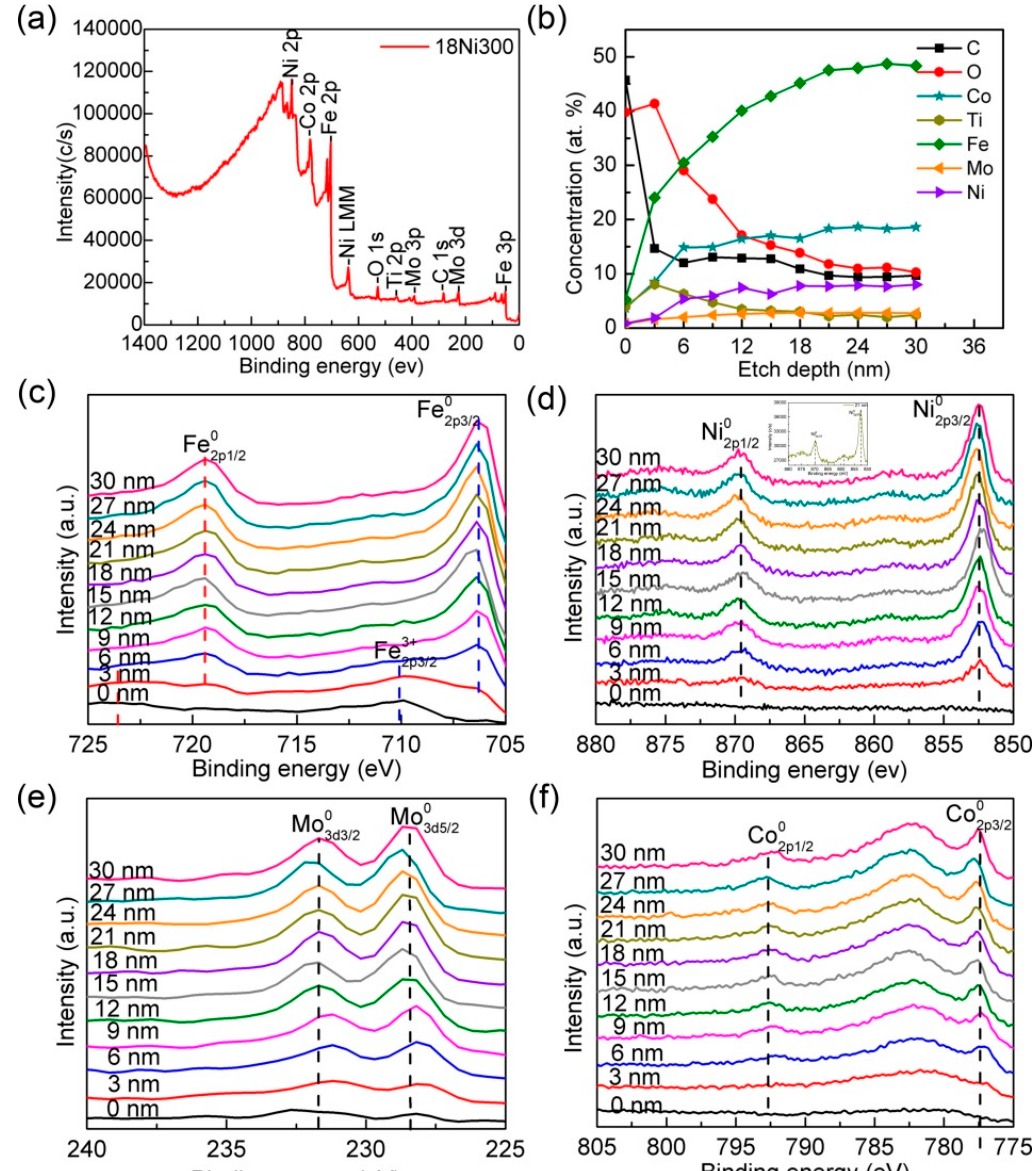
Figure A3. ( a ) XPS survey spectrum and ( b ) depth profile analyses of element concentrations, and detailed XPS spectra of ( c ) Fe, ( d ) Ni, ( e ) Mo and ( f ) Co on the surface of 18Ni300 powders in the as-received state and after ion etching up to 30 nm.